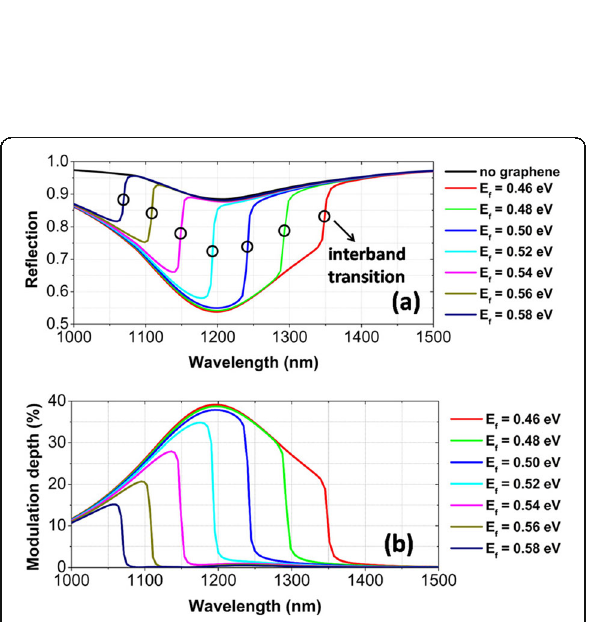
Fig. 4 Refection spectra ( a ) and modulation depth ( b ) for different E